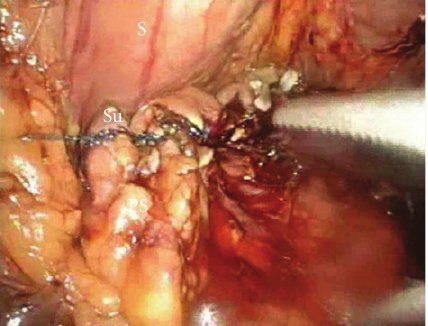
Figure 6: Pancreatic stump postsuturing (Su = sutures, P = pan- creas).